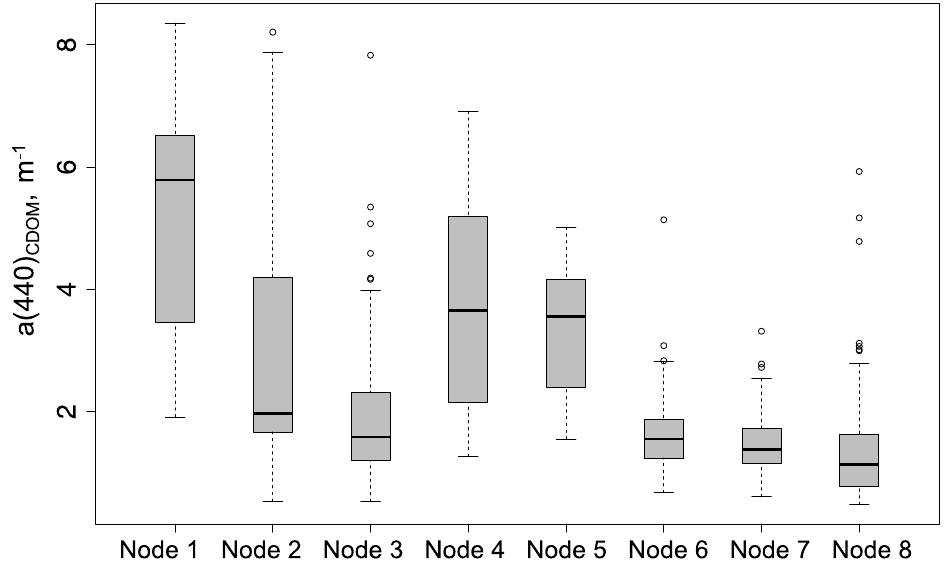
Figure 7. CDOM concentration of eight groups of lakes obtained from the regression tree model (RTM) (Figure 4). Numbers of the node can be taken from the Figure 4.